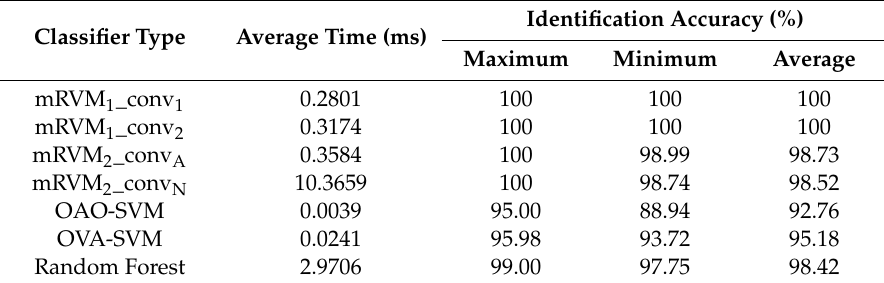
Table 8. Fault identification accuracy of di ff erent classifiers with the load 1 hp.